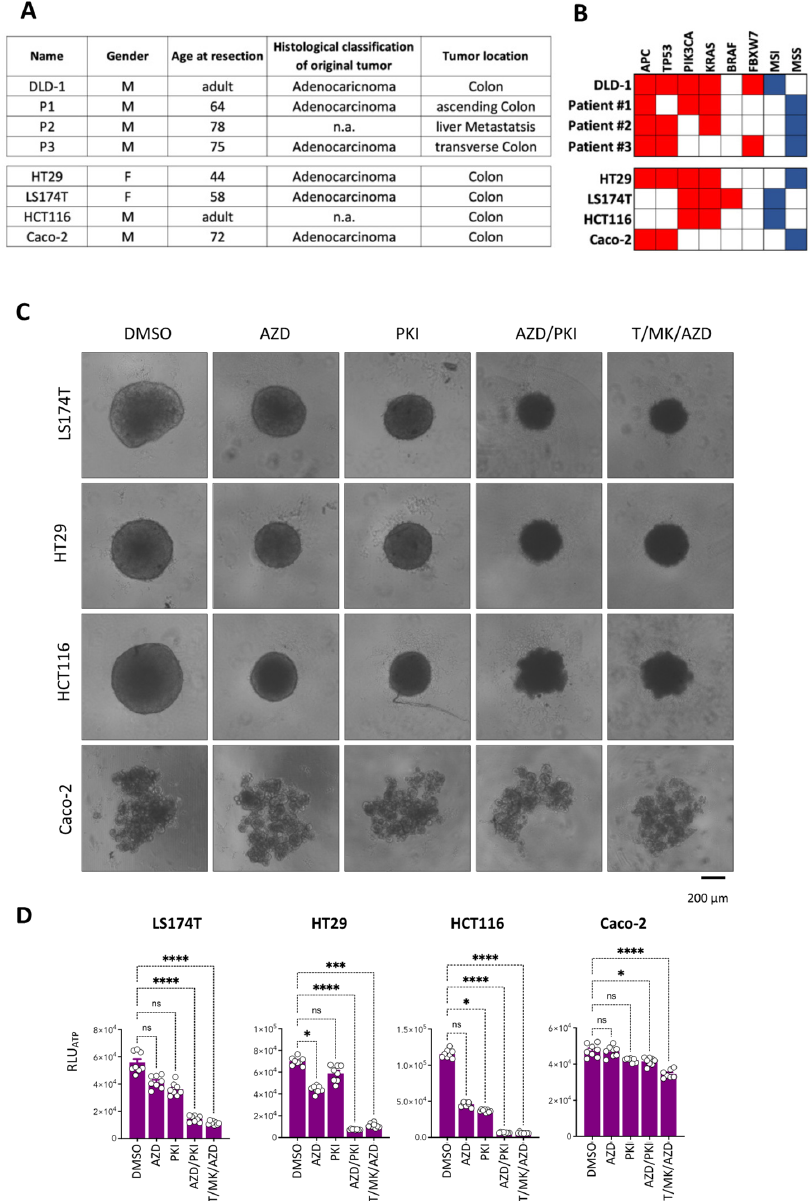
Figure 7. Treatment response correlates with mutational status in PI3K and/or KRAS. ( A ) Cell line and patient information. ( B ) Mutational (red) and microsatellite status (blue) of DLD-1 cells and the tumors from three patients (#1, #2, #3) of the most commonly mutated genes in CRC of which the organoids were derived (top panel). Mutations in other widely used CRC cell lines (bottom panel) used in this study. ( C ) Representative phase contrast microscopic images of spheroids of the indi- cated tumor cell lines treated with single inhibitors and combinations for 48 h. DMSO cultures are controls. Scale bar is 200 µm. ( D ) Cellular ATP levels determined with CellTiter-Glo 3D (CTG3D) after 48 h of spheroid treatment. Luminescence values (RLU ATP ) were determined ( n = 8 per condi- tion). Bar graphs are mean + standard deviation (SD), individual values are shown (circles). p -values are indicated by stars.